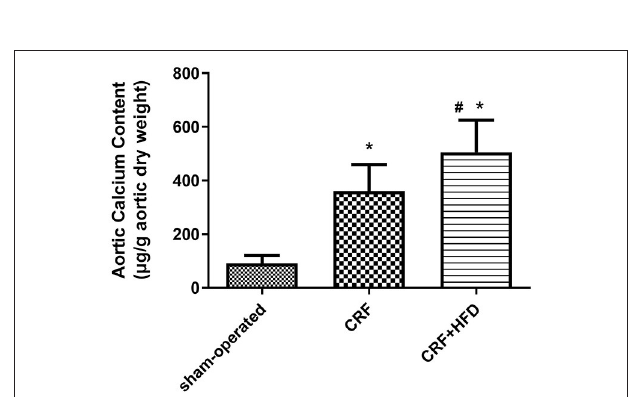
FIGURE 1 | Comparison of systolic blood pressure (A) and mean arterial pressure (B) of rats in each group. Six rats were included in each group. * P < 0.05 vs. sham-operated group; # P < 0.05 vs. CRF group. CRF, chronic renal failure; HFD, high fat diet; MAP, mean arterial pressure; SBP, systolic blood pressure.